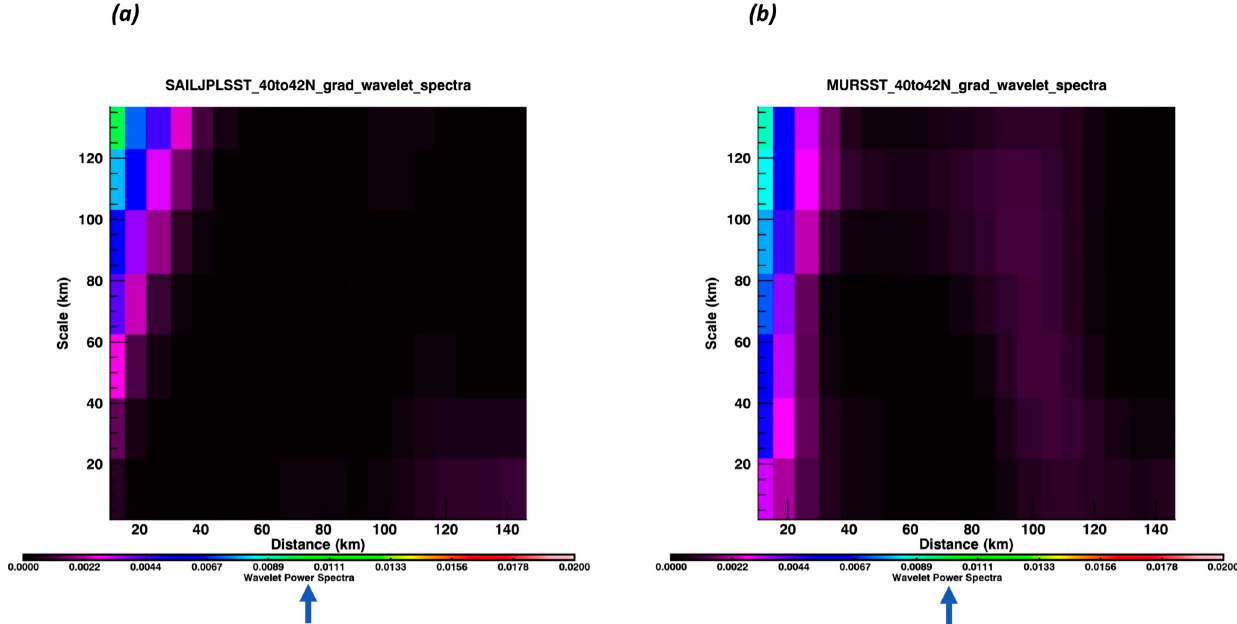
Figure 6. ( a , b ). Wavelet spectra from 38°N to 40°N for ( a ) SAILSST and ( b ) MURSST. Arrows indi- cate the color associated with the 95%level of confidence.